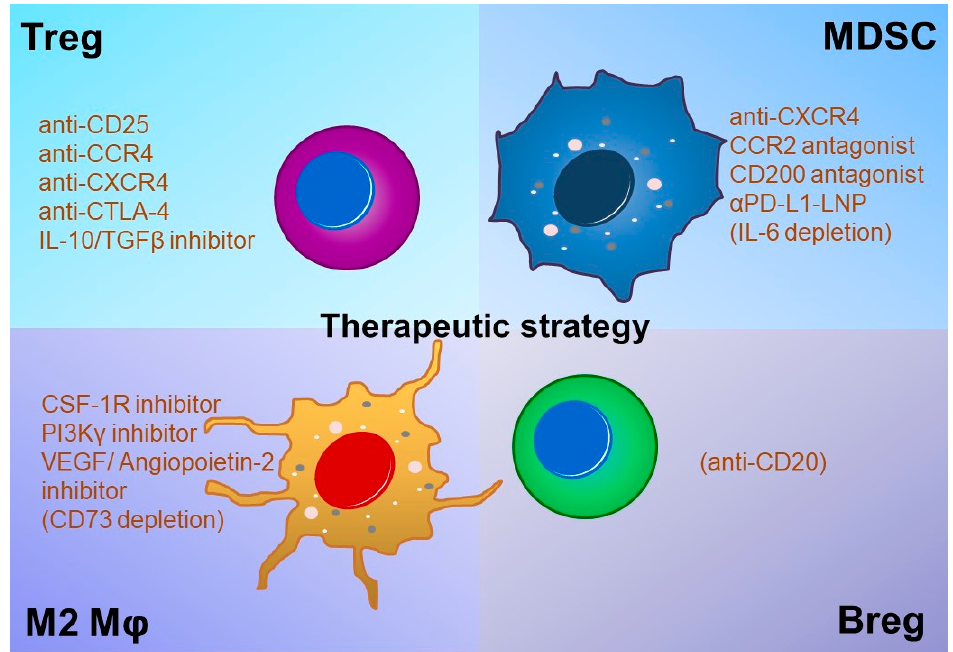
Figure 4. Treatment candidates for Tregs, MDSCs, M2M φ , and Bregs in the glioma microenvironment.